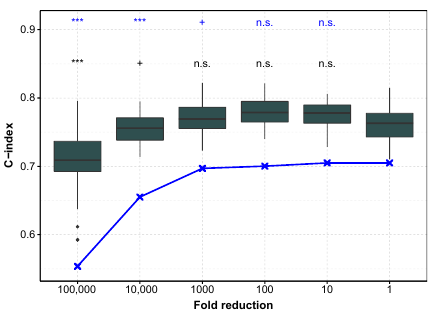
Figure 2. C-index as a function of sequencing depth reduction tested on the E-MTAB-1980 dataset and TCGA subset for mRNA profiling in ccRCC. In dark gray, performance measured with the C-index calculated on the E-MTAB-1980 dataset, after training on an 80% sub-sample of the TCGA dataset (the procedure is repeated to obtain 50 C-indices). In blue, the test is performed on the remaining 20% of TCGA data (median C-index). ***: p ≤ 0.001, +: p < 0.1, n.s.: p ≥